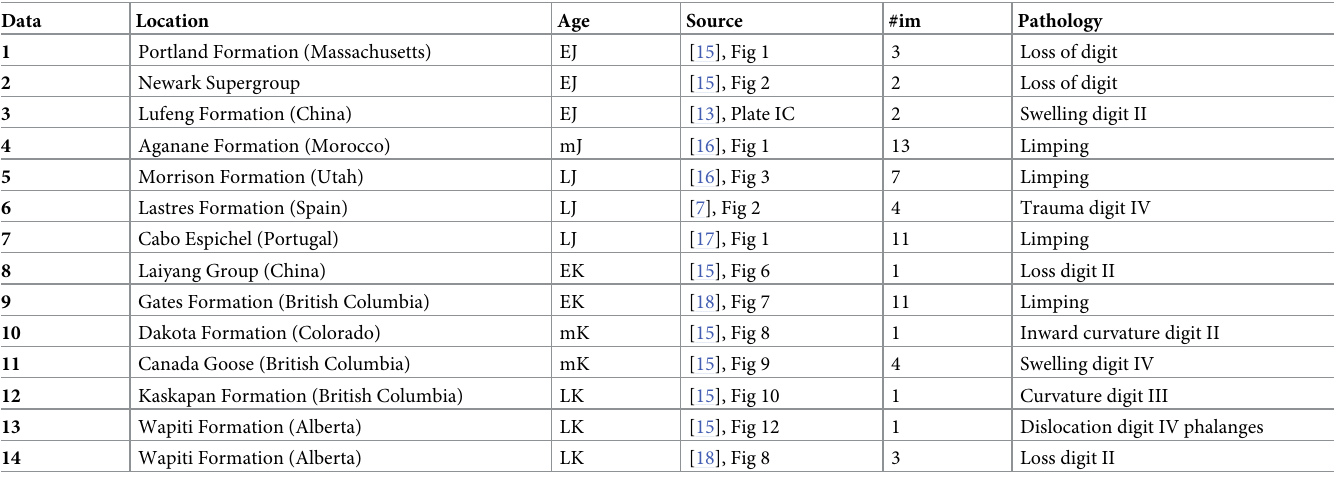
Table 1. Pathological feet in dinosaurs.